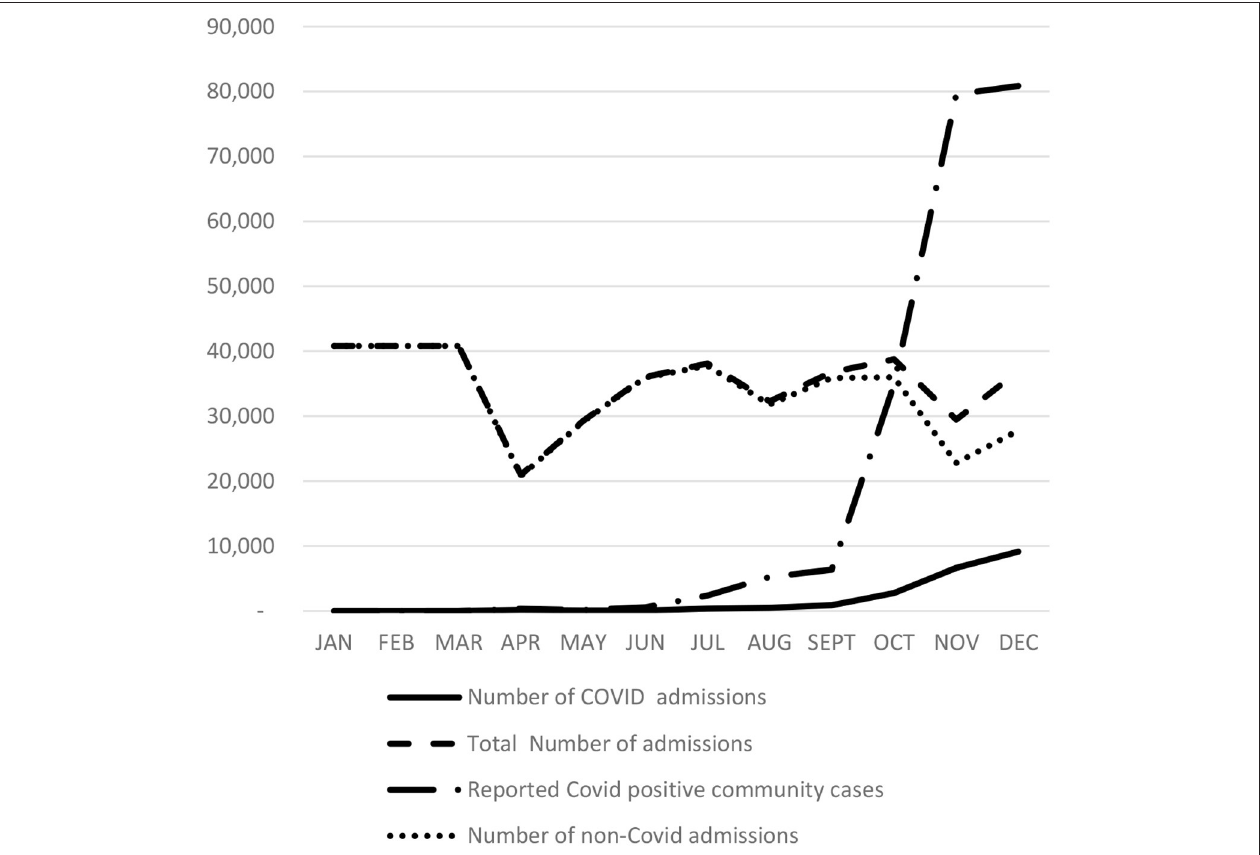
FIGURE 1 | Comparison of Total Monthly Admissions, COVID-19 Related and non-COVID-19 Admissions. Source: Monthly admission data from CHIF—January, February, March data is an average for the first quarter of 2020; Covid-19 admission data from PHI (PHI begun recording Covid-19 data on 14th April,